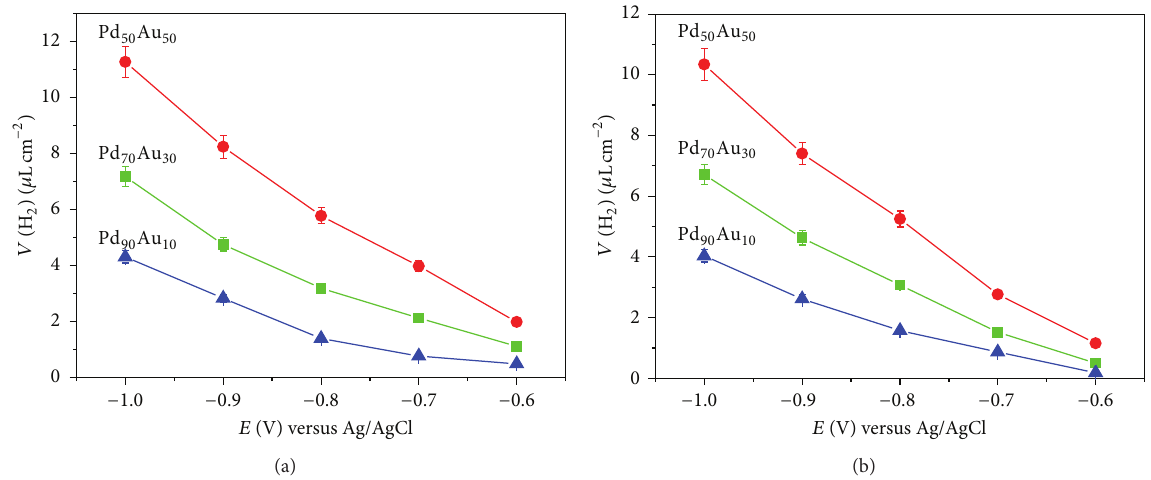
Figure 7: Quantities of evolved hydrogen at different applied potentials estimated from (a) MS data; (b) chronoamperometric measurements.